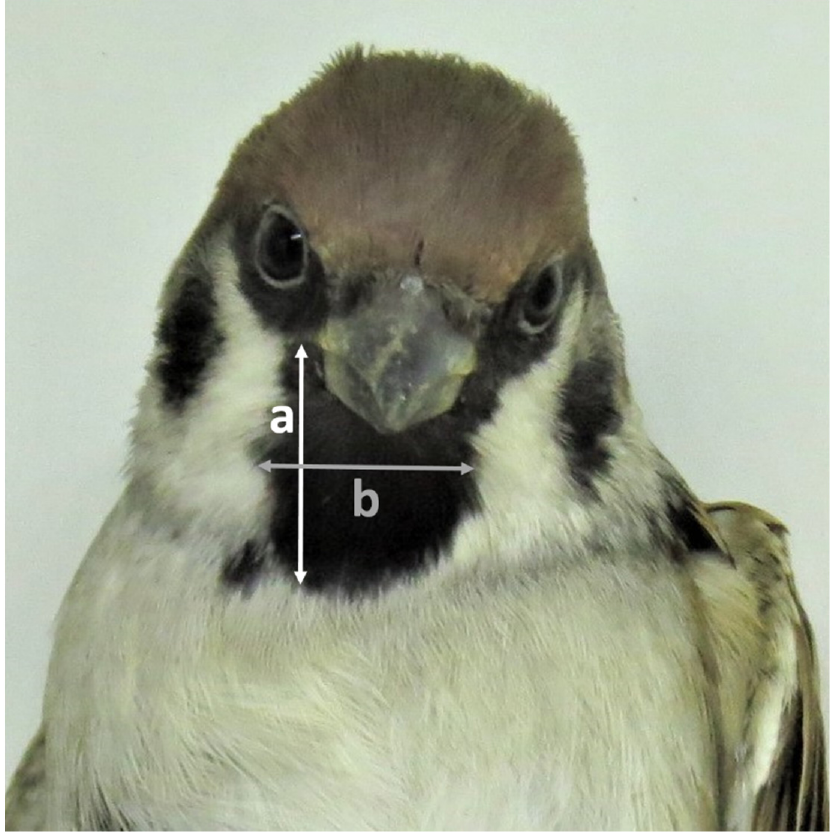
Figure 2. Measurement points for the height ( a ) and width ( b ) of the badge of the Eurasian Tree Sparrow.